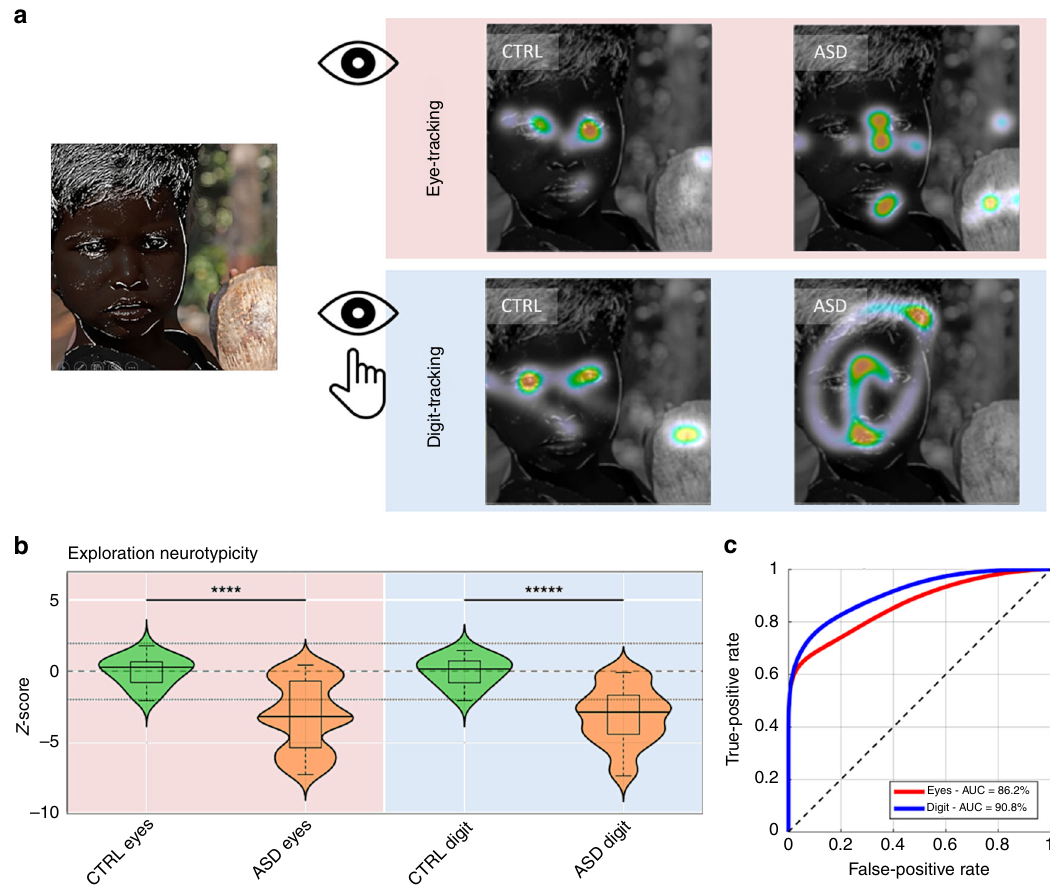
Fig. 5 Detection of abnormal visual explorations in autistic spectrum disorders (ASD). a Typical exploration behaviors observed in four subjects (two ASD and two control subjects), recorded with either eye-tracking or digit-tracking. High-functioning autistic patients (ASD) tend to adopt an atypical face exploration strategy that avoids the eye area. Note similarities in the explorations, even if they are recorded with different methods on different subjects. b Results of the group analyses: For each subject, a single score was calculated to quantify the neurotypicity of attention maps obtained in patients ( N = 22) and control subjects ( N = 22). Both methods (Eye-tracking and digit-tracking) detect anomalies in the attention maps of the ASD population (respectively p eye <0.0001 and p digit < 0.00001 – Wilcoxon rank-sum test) and are correlated (Spearman rho = 0.56 p <0.0002). c Receiver Operating Characteristic (ROC) curves for ASD/CTRL classi fi cations with the ‘ exploration-neurotypicality score ’ . Please note that original faces have been modi fi ed to hide individuals ’